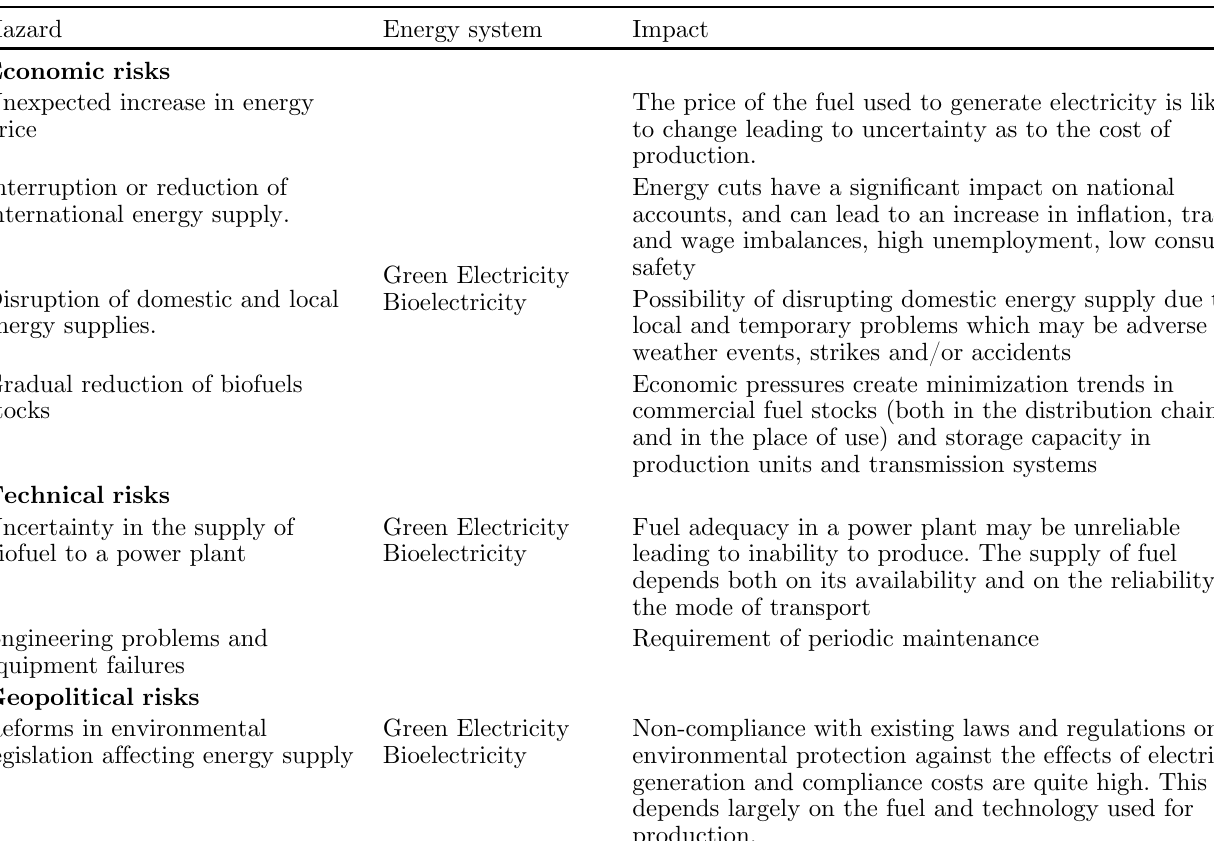
Table 3. Economic, technical, and geopolitical risks impact on electricity supply